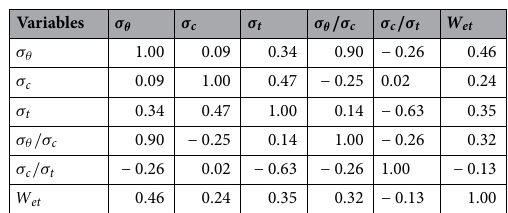
Table 3. The correlation coefficient of each